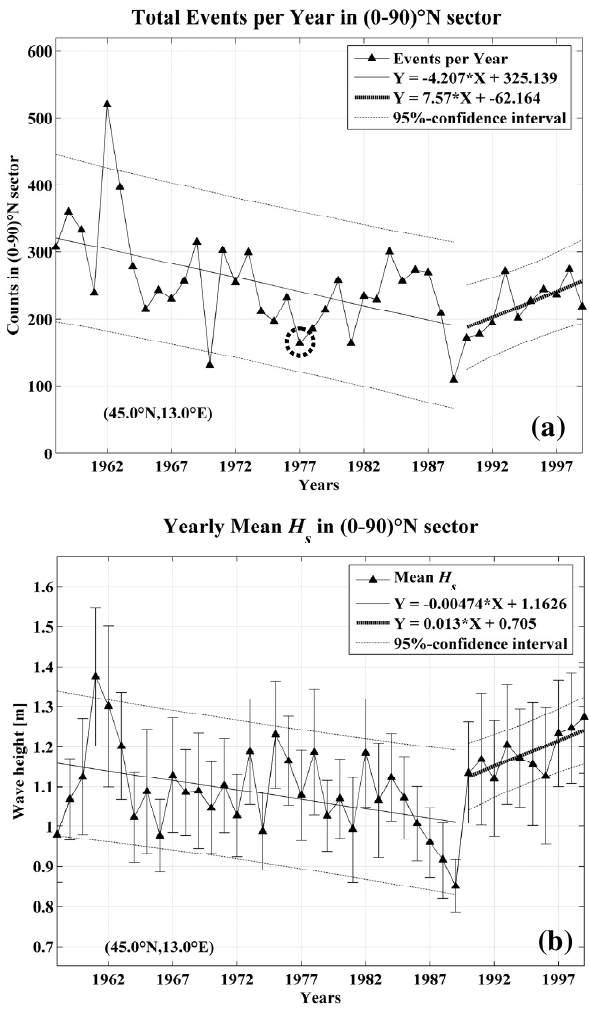
Fig. 5. Panel (a) and panel (b) show, for the period 1958–1999, respectively, the annual total number of sea-states and the mean annual H s values in the sector of (0–90 ◦ N) incoming wave direction. Two linear fits for each panel display the trends over the year ranges 1958-1989 and 1990-1999. Dash-dotted lines around the regression lines indicates the 95%-confidence intervals. The circle in panel (a) shows the first turning-point in 1977. Error bars on panel (b) have amplitude equal to two times the annual H s standard deviations.